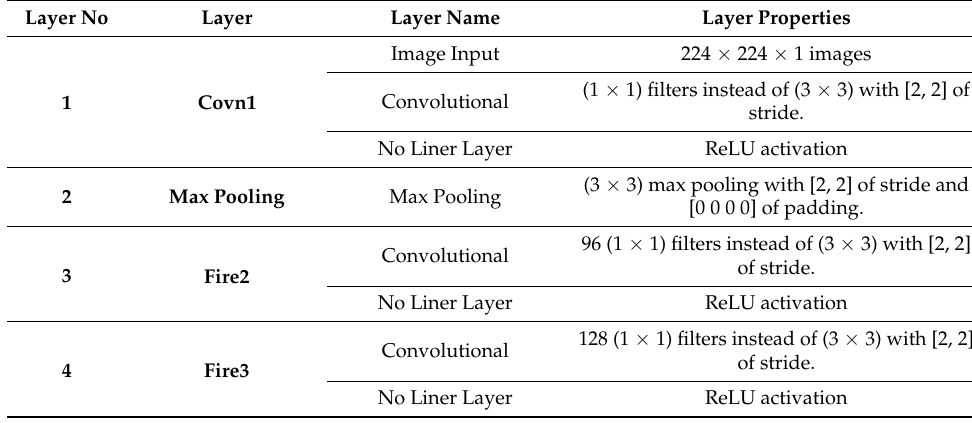
Table 1. Details of layers of the SqueezeNet network.